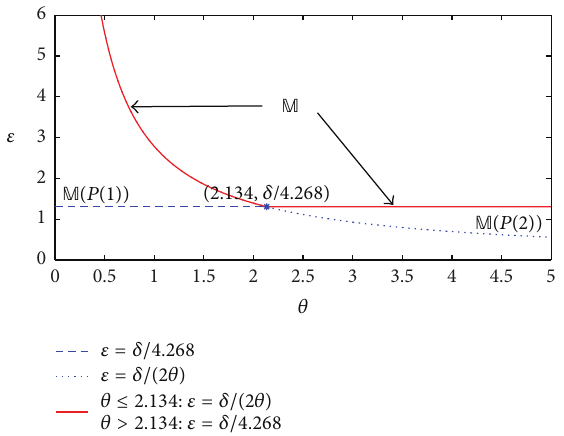
Figure 2: Thresholds for the attractiveness of the synchronization manifolds M (𝑃(1)) , M (𝑃(2)) , and M